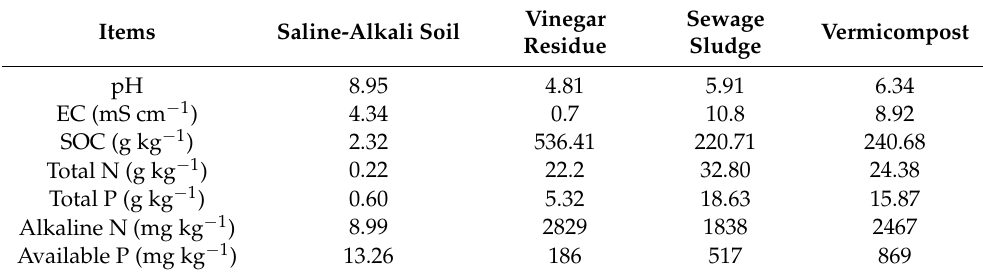
Table 1. Basic properties of saline-alkali soil and exogenous organic materials used in this study. Items Saline-Alkali